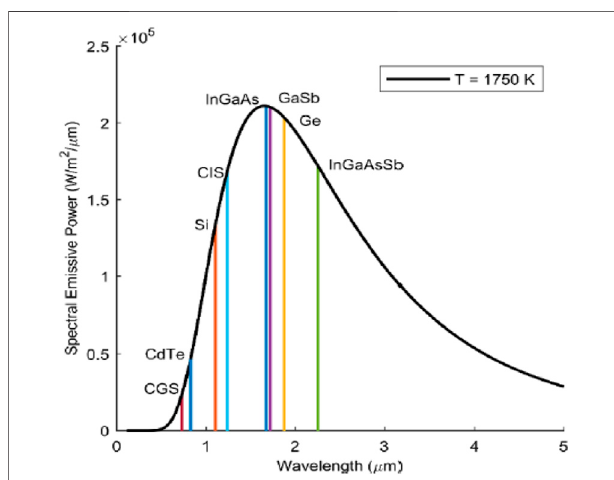
FIGURE 8 | Distribution of spectral emissive power (W/m 2 / μ m) against wavelength ( μ m) at an average emitter temperature of 1750